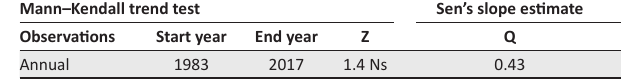
TABLE 5: Trend of annual (mm) rainfall in Harshin from 1983 to 2017.